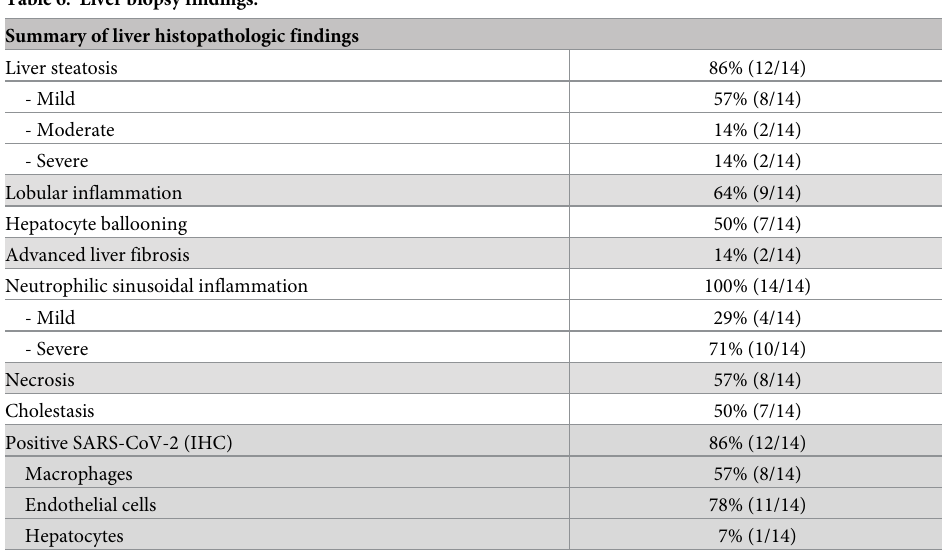
Table 6. Liver biopsy